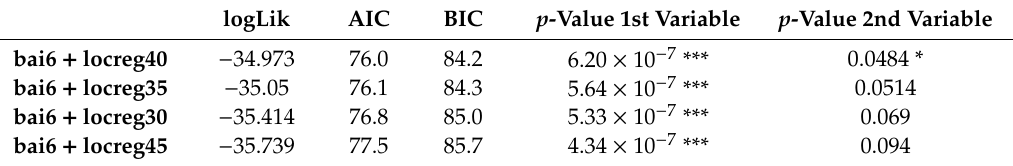
Table 5. Best models with two explanatory variables: Growth level and growth trend, ranked according to AIC